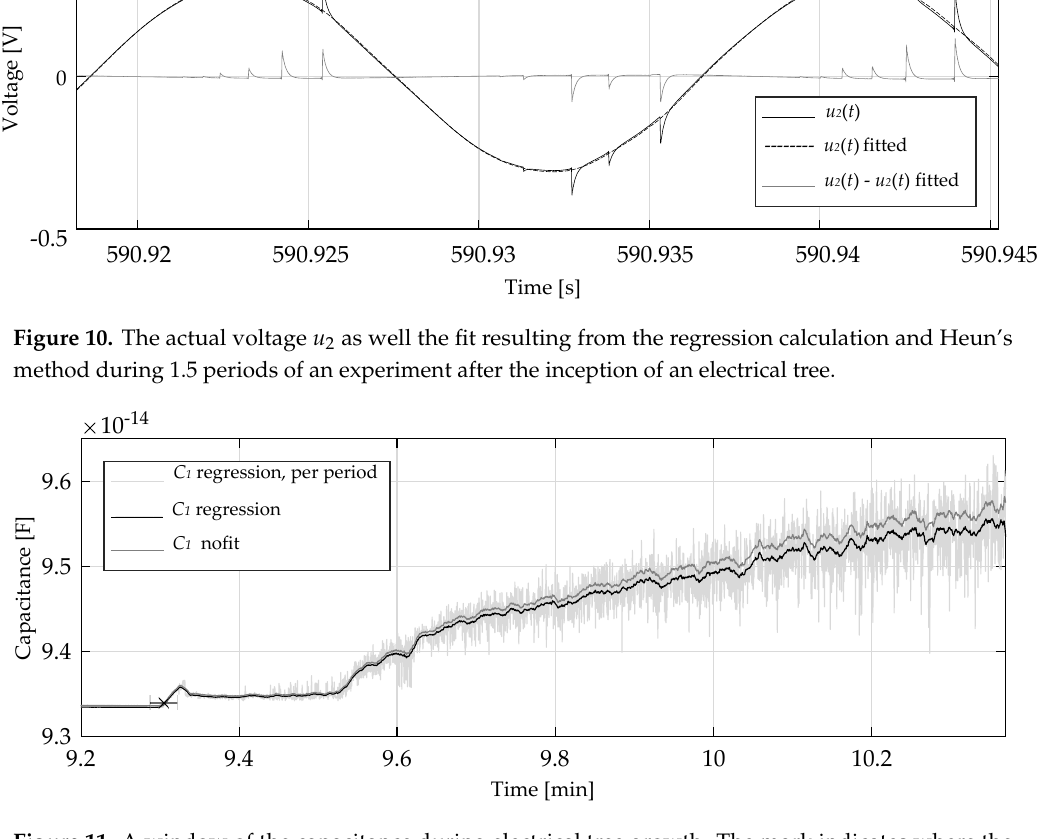
Figure 11. A window of the capacitance during electrical tree growth. The mark indicates where the electrical tree was detected optically. “ C 1 regression” and “ C 1 nofit” are results of rolling average of 43 periods. Nofit refers to a simple j w -calculation where no effort has been made to lessen the influence of the ongoing PD-activity on the capacitance.